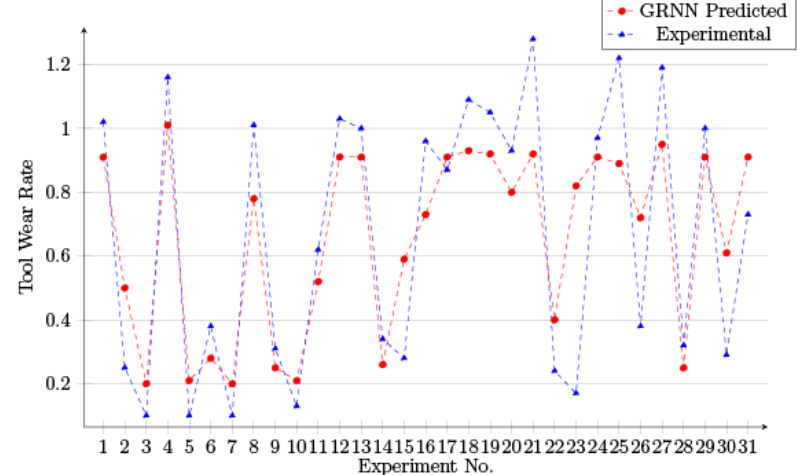
Figure 11. Experimental and GRNN predicted values for TWR training data.